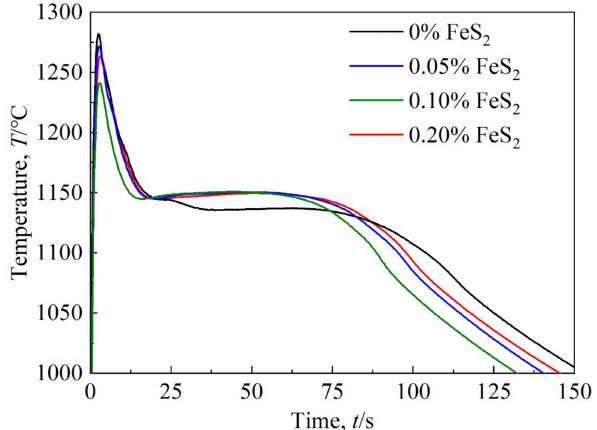
Figure 6. Comparison of cooling curves with different content of FeS 2